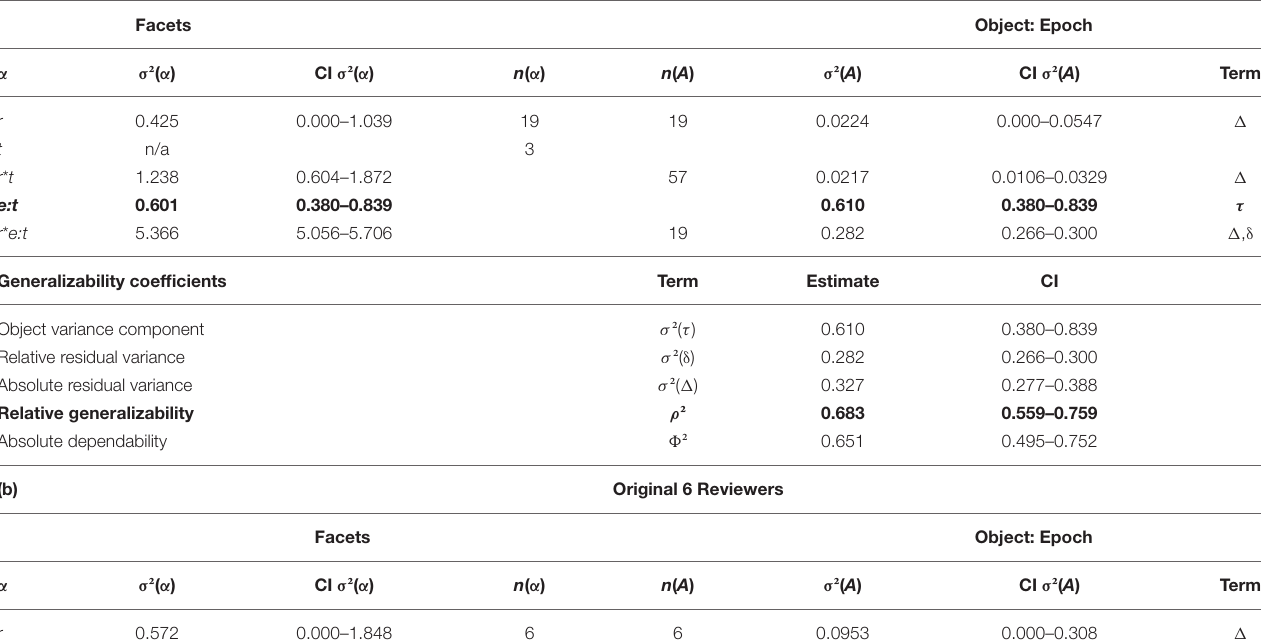
TABLE 1 | Generalizability study details for each of the groups of